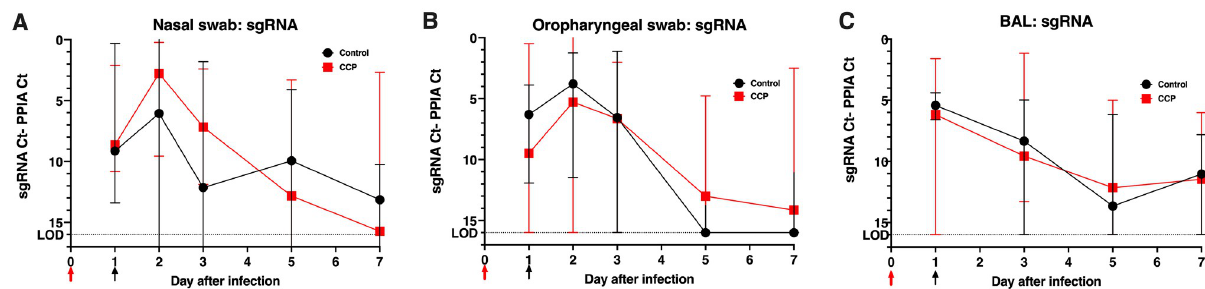
Fig 4. Lack of detectable effect of convalescent plasma on viral subgenomic RNA levels in upper and lower respiratory tract secretions. (A) to (C) Time course of median viral subgenomic (sg) RNA copies (with error bars showing the range) in nasal swabs, oropharyngeal swabs and BAL samples, respectively. Red and black arrows indicate time of virus inoculation and infusion of plasma (control plasma or CCP) on days 0 and 1, respectively. sgRNA was measured by RT-qPCR and expressed relative to cellular mRNA of the housekeeping gene PPIA (as indicator of the cellular content in the sample tested) by plotting the difference in CT values; thus, a larger difference indicates less virus replication. The dotted line indicates the limit of detection (LOD). More details are provided in S7 and S8 Figs.